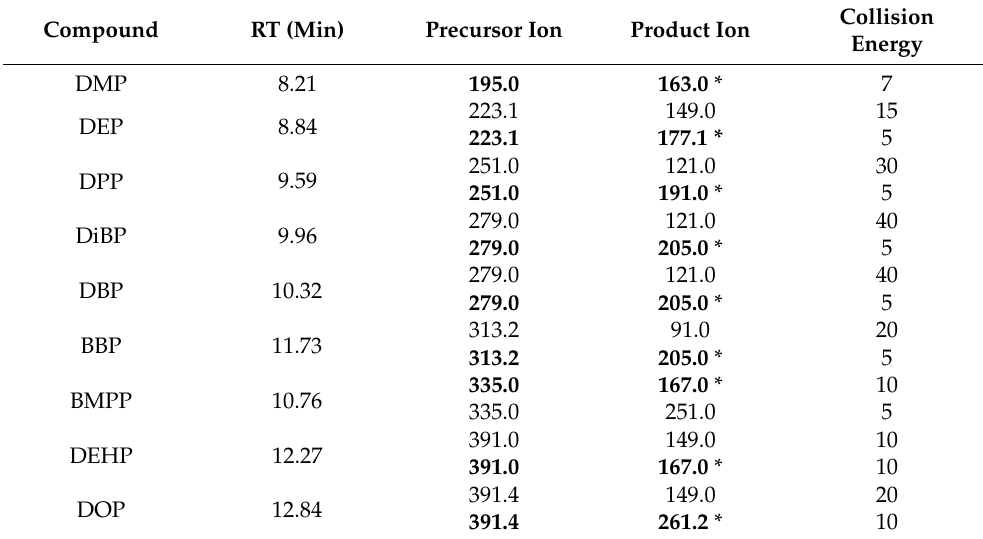
* Transitions used for quantitation of phthalates.